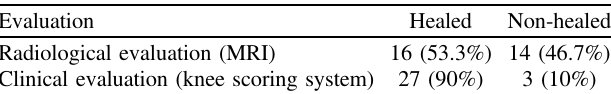
Table 3. Clinical and radiological evaluation of 30 patients who had MRI at 6 months